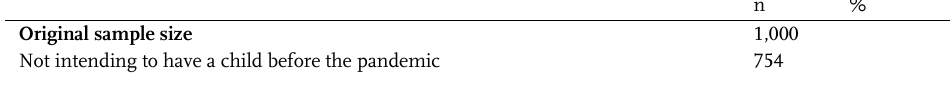
Table 2 : The declared change in childbearing intentions due to COVID-19 Original sample size